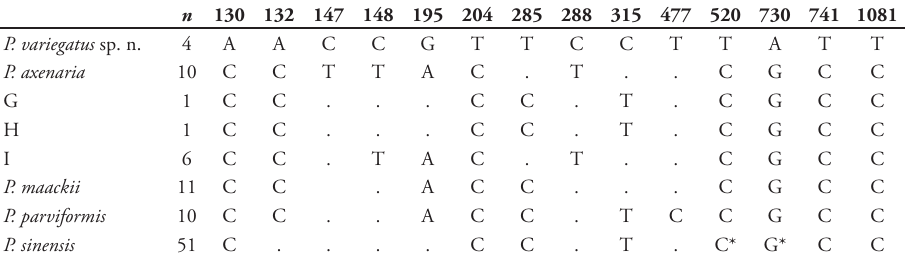
*Among 51 sequences of P. sinensis , only the holotype had the same character state as P.